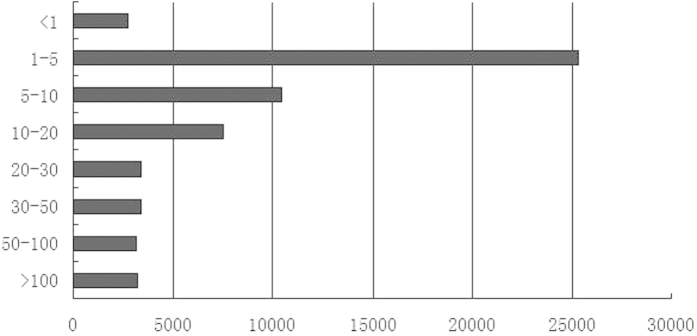
A histogram of the average read-depth coverage for unigenes.The x-axis indicates the number of unigenes, and the y-axis indicates the distribution of read-depth coverage.